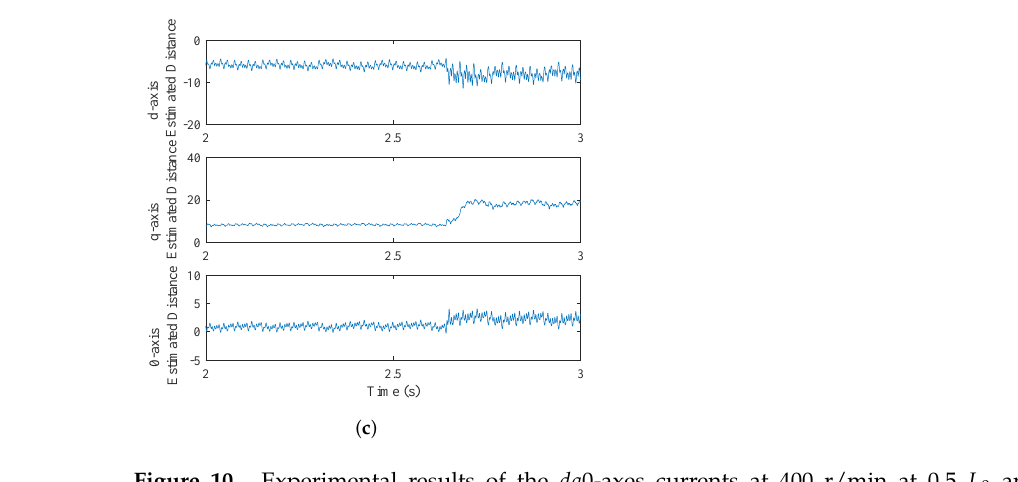
Figure 10. Experimental results of the dq 0-axes currents at 400 r/min at 0.5 L 0 and 0.5 L 1 . ( a ) 2DOF IMC method. ( b ) 2DOF IMC ADO method. ( c ) Estimated